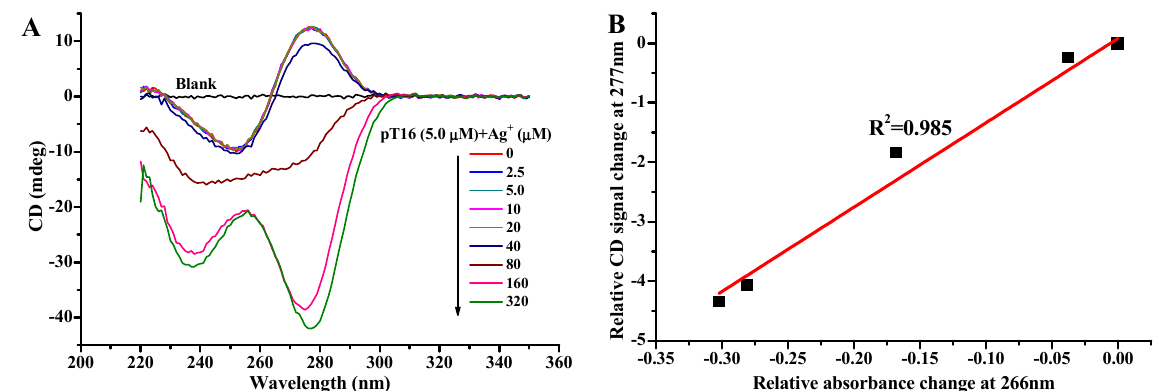
Figure 3. ( A ) CD spectra of 5.0 μ M pT16 in the absence and presence of 2.5, 5.0, 10, 20, 40, 80, 160, and 320 μ M AgNO 3 . ( B ) The relationship between the relative CD signal change at 277 nm and the absorbance change at 266 nm. The reaction conditions are the same as those for Figure 1.